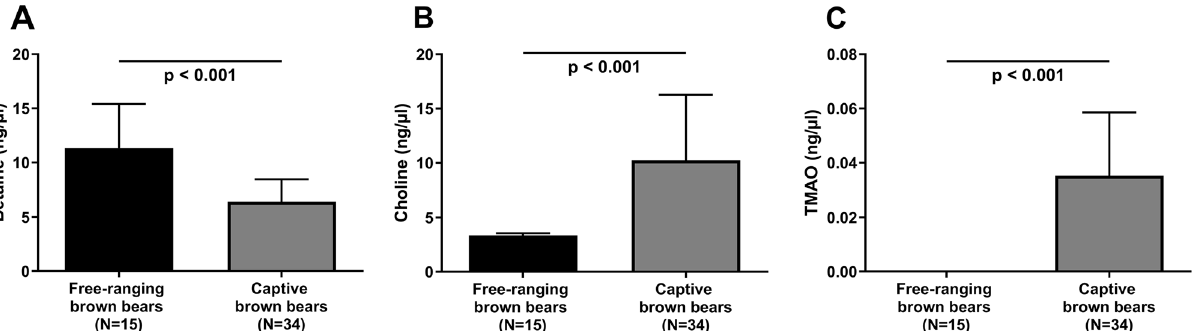
Figure 5. Circulating levels of ( A ) betaine, ( B ) choline, and ( C ) trimethylamine N-oxide (TMAO) in active, free-ranging brown bears (black bars) compared to captive brown bears from European zoos (grey bars). Results are shown as median (interquartile range). p values between the two groups were assessed by non-parametric Mann–Whitney U test. Number of animals included in each group is depicted. TMAO levels could only be detected in one out of 15 free-ranging brown bears.